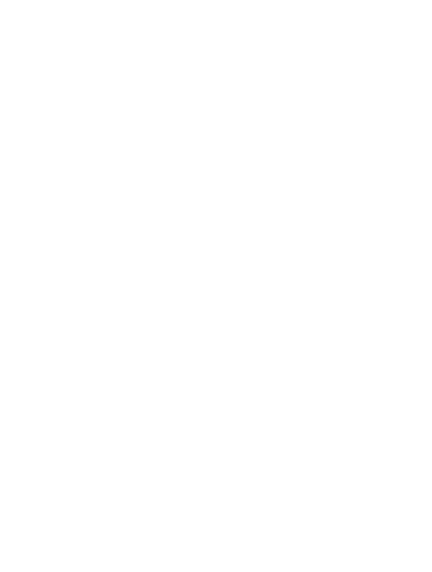
Table 4. Known-group validity